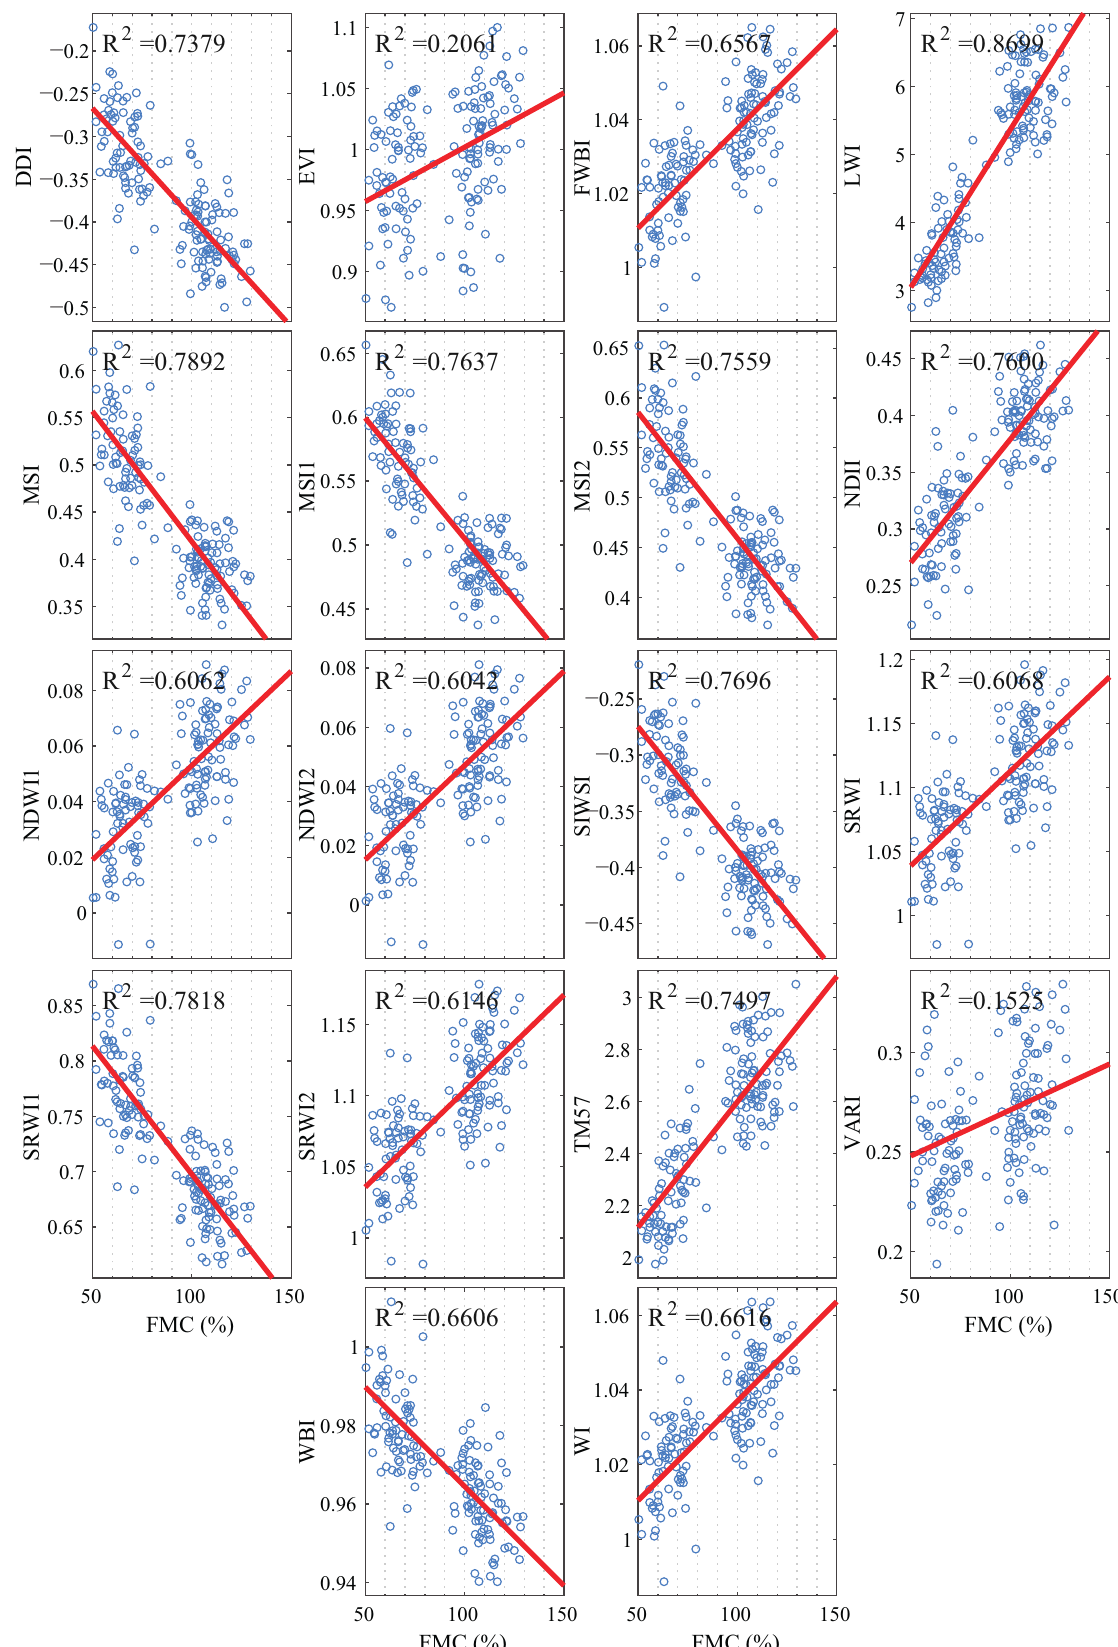
Figure A2. VIs variation as function of Fuel Moisture Content for Eucalyptus globulus